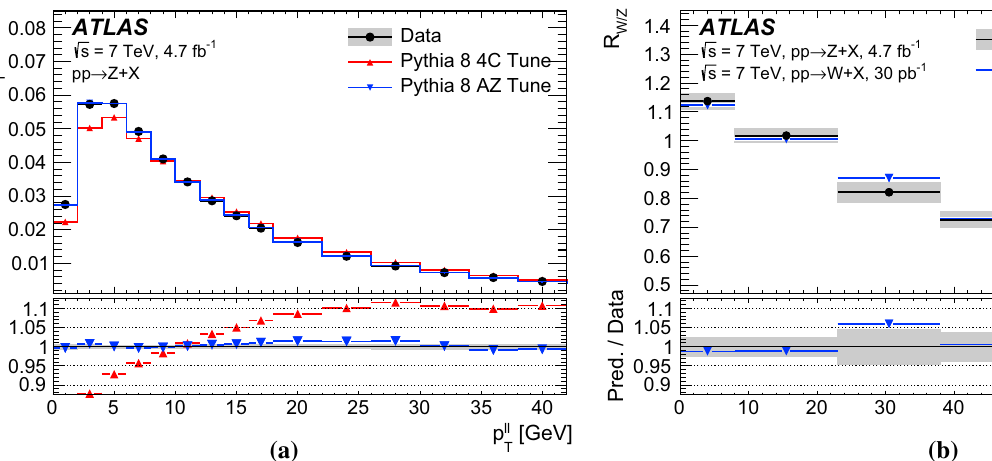
Fig. 1 a Normalised differential cross section as a function of p (cid:7)(cid:7) Z -boson events [44] and b differential cross-section ratio R W / Z ( p T ) as a function of the boson p T [44,45]. The measured cross sections are